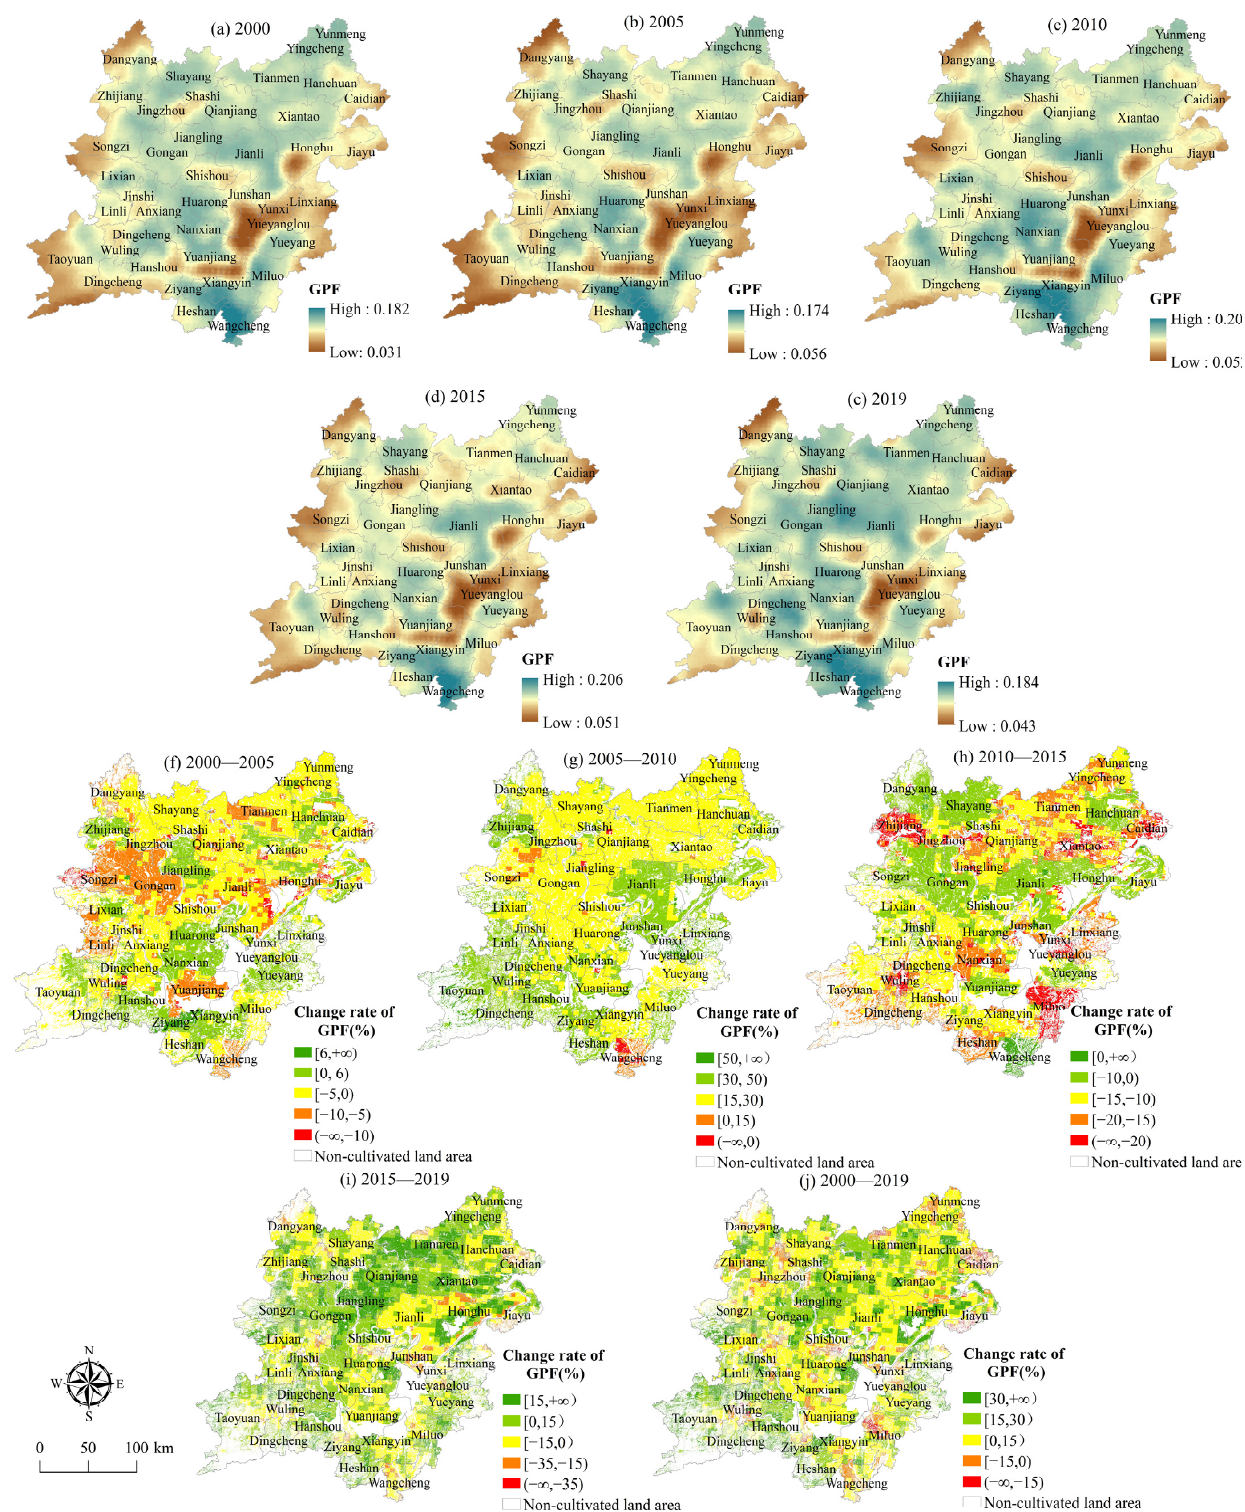
Figure 6. Spatial distribution of grain production function index.